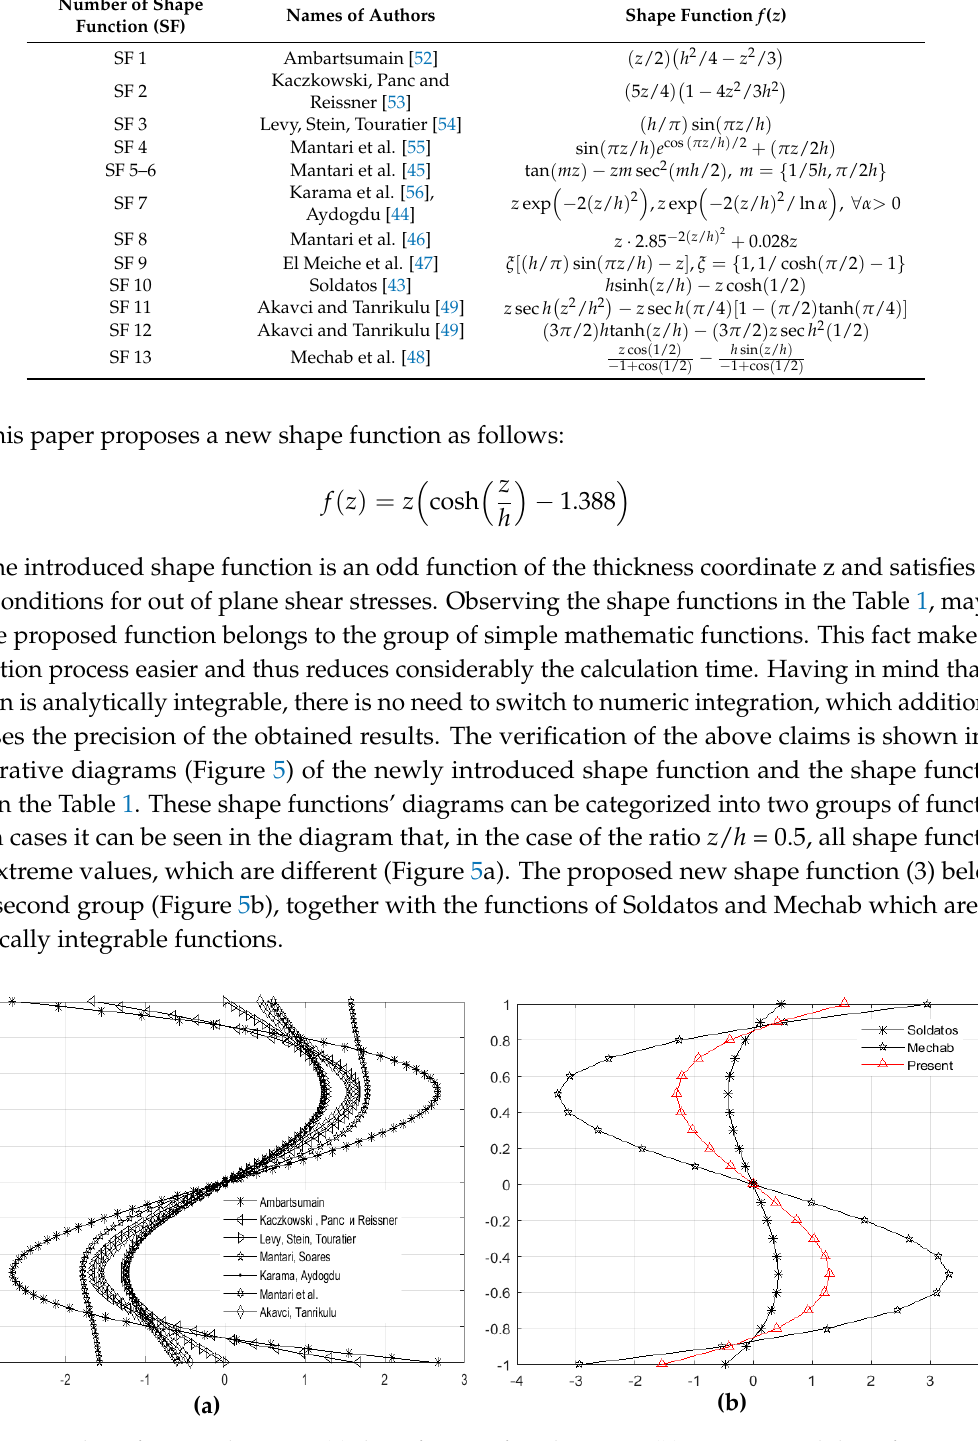
Figure 5. Shape function diagrams: ( a ) shape function from literature; ( b ) new proposed shape function. For small displacements and moderate rotations of a transverse normal in relation to x axis and y axis, normal and shear strain components are obtained by well-known relations in linear elasticity between displacements and